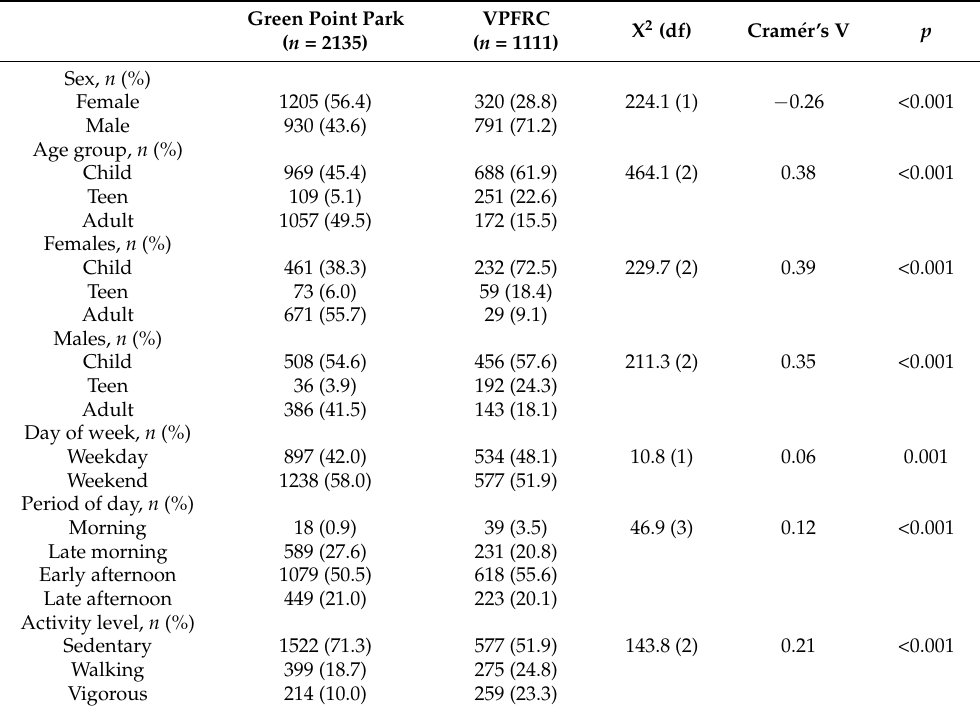
Table 6. Associations in observed park and user characteristics between Green Point Park and Valhalla Park Family Recreation Centre.